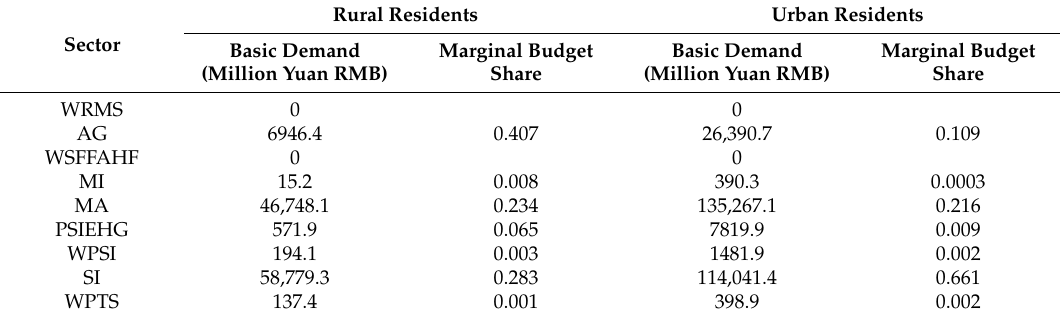
Table 3. The parameters of linear expenditure system (LES) demand function ( θ c , h ) of each sector.